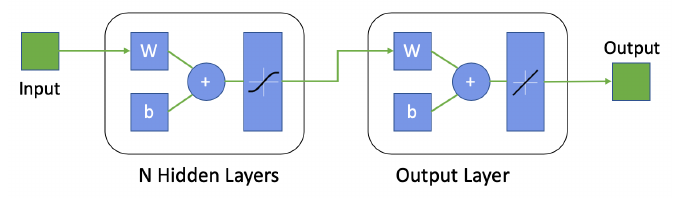
Figure 13. The structure of The neural network